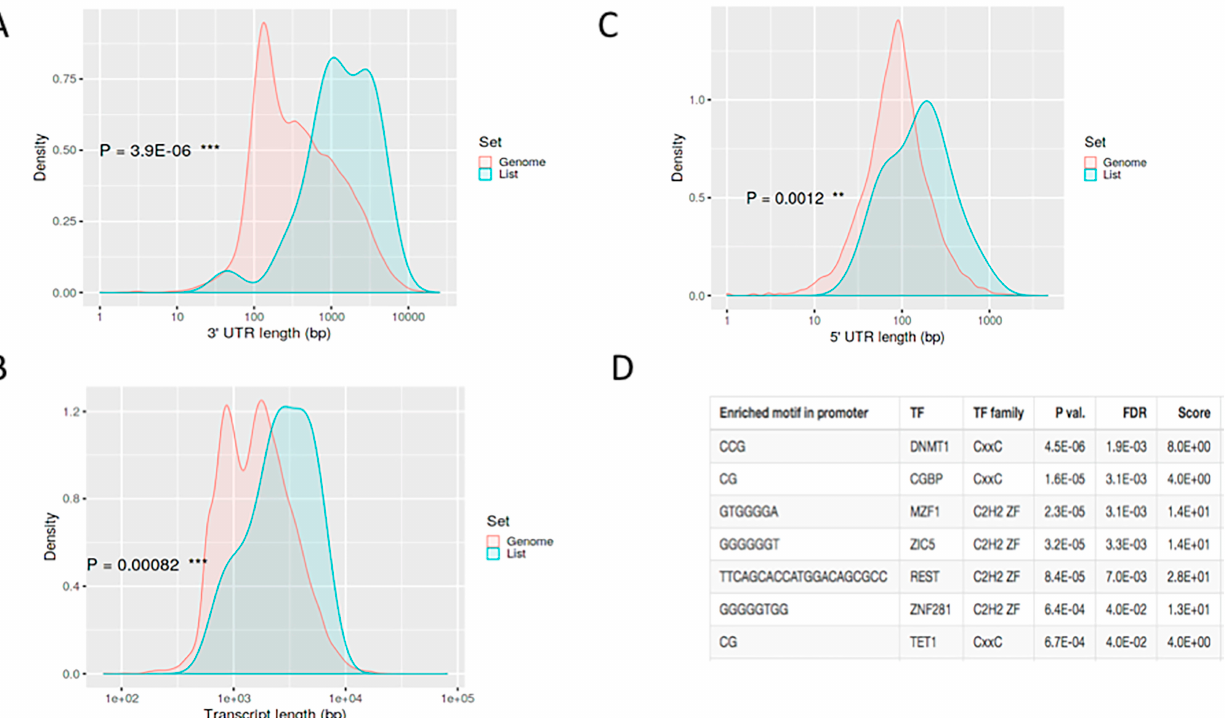
Figure 4. Identification of post-transcriptional regulation genes in A.baumannii infection. ( A ) 3 (cid:48) untranslated region (UTR) and ( B ) 5 (cid:48) UTR length analysis shows that downregulated genes have longer untranslated regions. ( C ) Transcript length analysis shows an increased transcript length for downregulated genes. ( D ) Analysis of motif enrichment in gene promoter regions suggests that several transcription factors may play a role in downregulating certain genes in response to A. baumannii infection. The explanation for , *, ** and *** is as follows: * p -value < 0.01; ** p -value < 0.001; *** p -value <